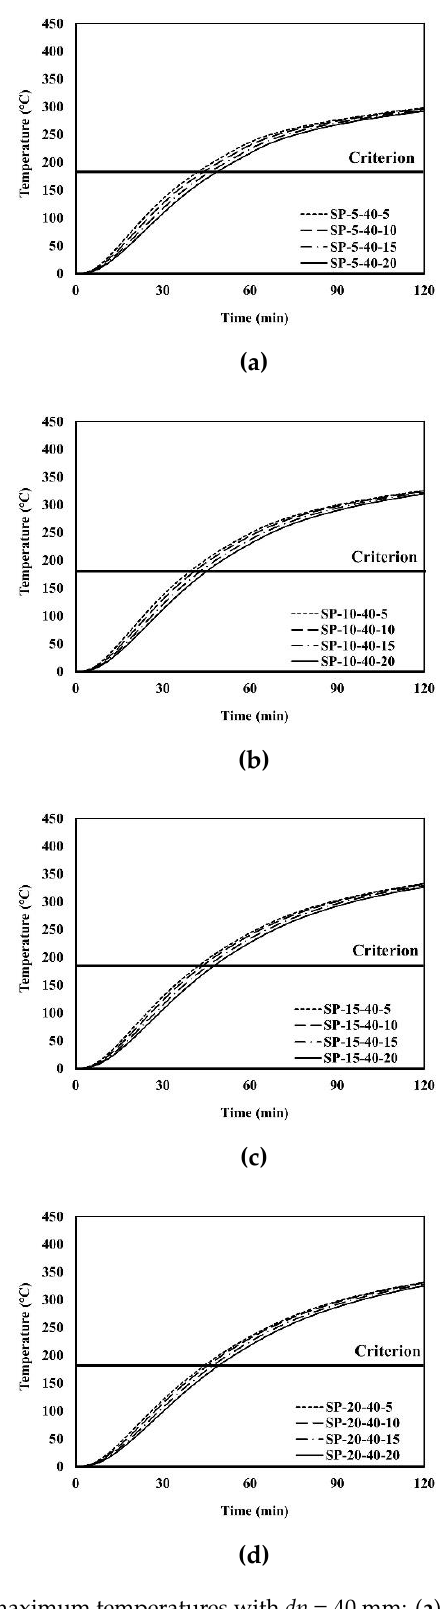
Figure 15. Time history of maximum temperatures with dp = 40 mm: ( a ) SP-5-40-x; ( b ) SP-40-20-x; ( c ) SP-15-40-x; ( d ) SP-20- 40-x.